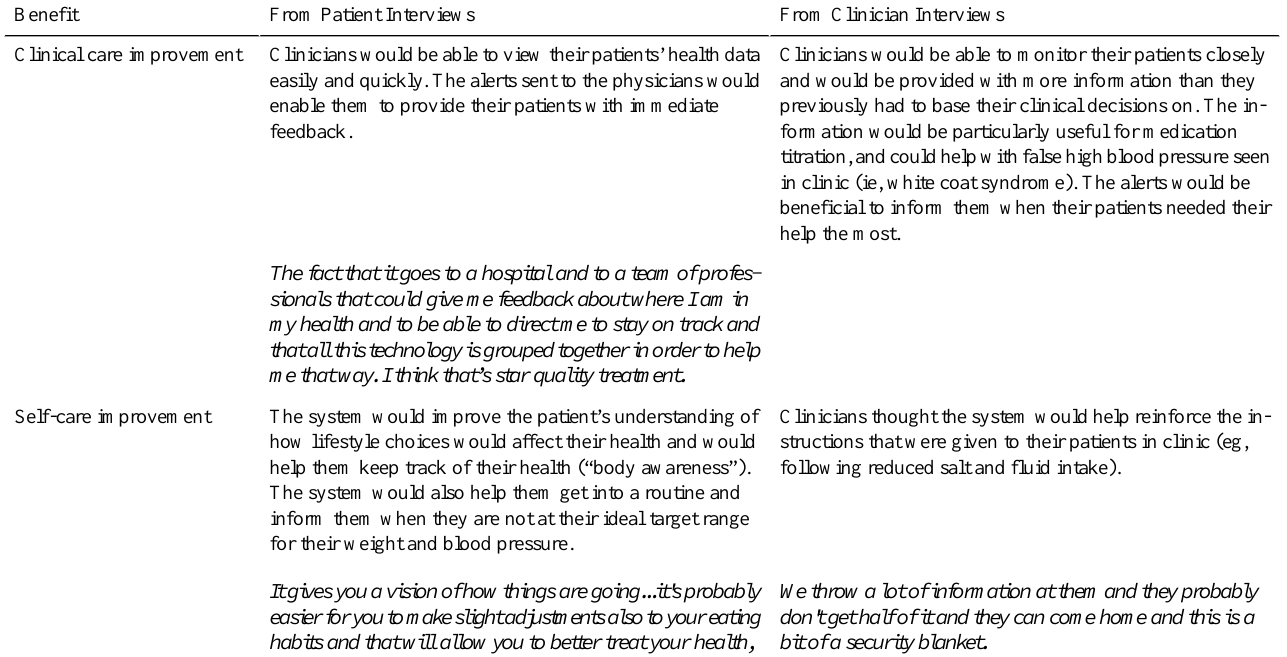
From Clinician InterviewsFrom Patient